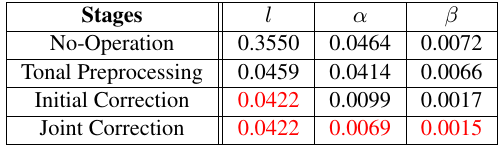
Table 1. Average tonal differences in l , (cid:11) and (cid:12) channels after different processing stages for synthetic image